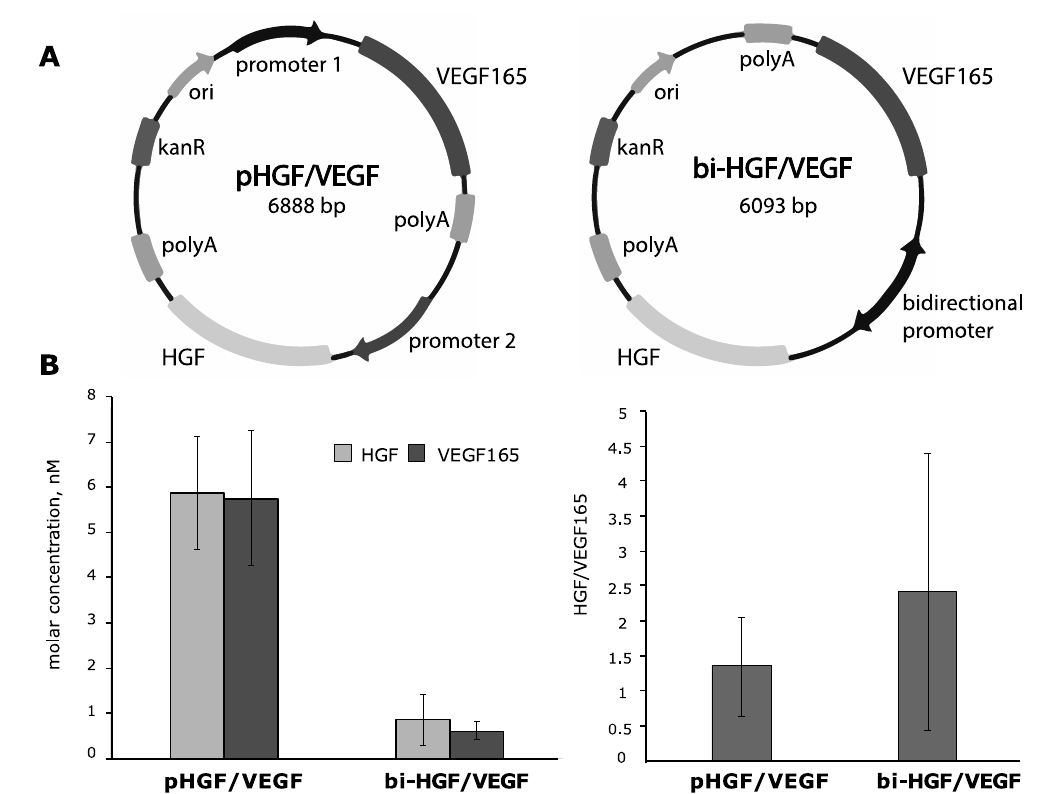
Figure 3. Design of bicistronic plasmids and result of expression activity analysis in HEK293T culture. ( A ) Schematic maps describing design principles of tested bicistronic vectors: pHGF / VEGF plasmid with two di ff erent promotors for HGF and VEGF165 genes and bi-HGF / VEGF plasmid with bidirectional CMV promotor. ( B ) HGF and VEGF165 concentrations and their ratio in culture medium from HEK293T cells transfected by pHGF / VEGF and bi-HGF / VEGF plasmids. Data are presented as mean ± SEM.